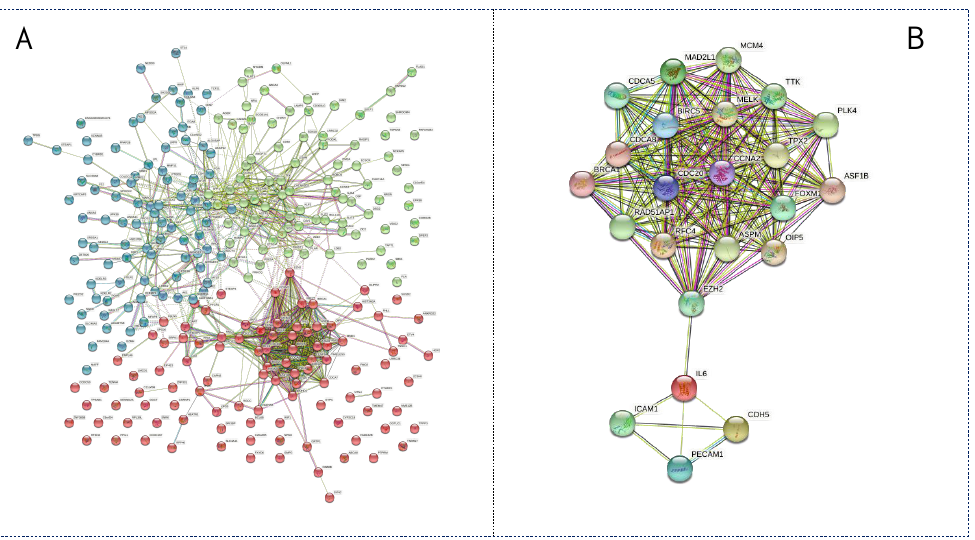
Figure 3. STRING network analysis of identified DEGs. ( A ) Full network of the DEGs. The different colors indicate the different groups in this figure. ( B ) Key part of the network. The colored nodes indicate the query proteins and the first shell of interactors; the white nodes indicate the second shell of interactors; the red edges indicate the experimentally determined protein–protein interactions; the green edges indicate the gene neighborhood of interaction; the black edges indicate the co-expression of interaction; the yellow edges indicate the text mining of interaction; the blue edges indicate the gene co-occurrence of